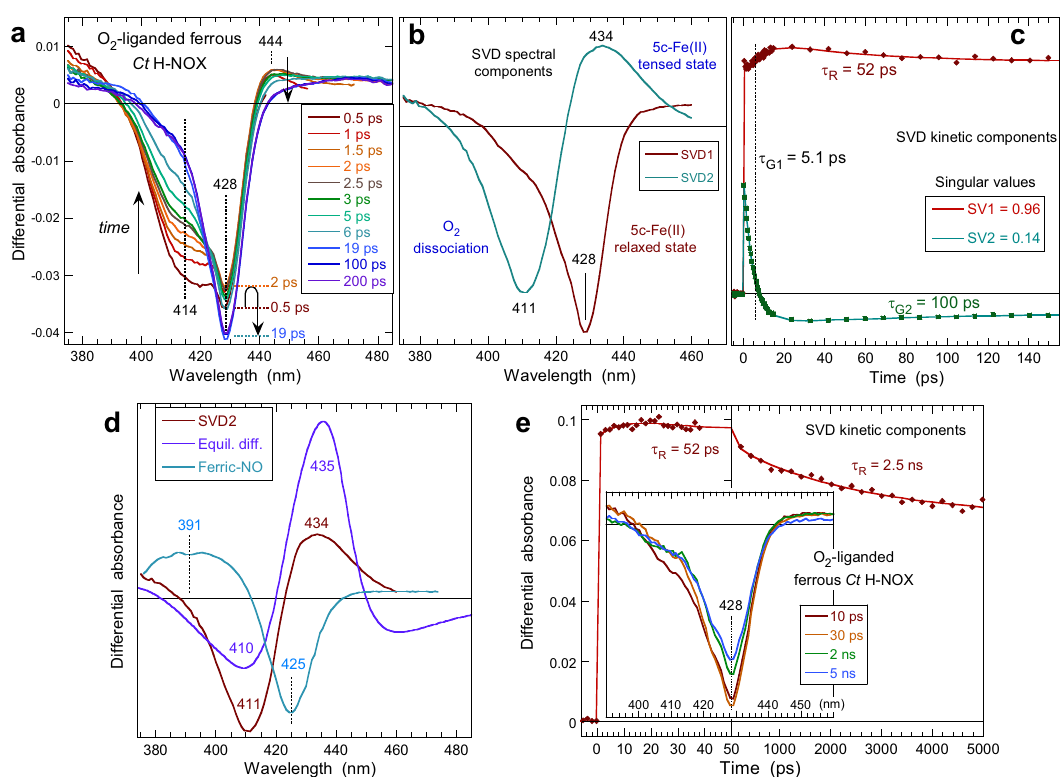
Fig. 2 Dynamics in ferrous O 2 -liganded Ct H-NOX. a Transient difference absorption spectra (spectra at positive delay minus spectrum at negative delay) after the photodissociation of O 2 from ferrous heme at increasing time delay ( λ ex = 564nm). b Spectral components from Singular Value Decomposition analysis of the time-wavelength data matrix of Ct H-NOX – O 2 . c Associated SVD kinetic components fi tted to the sum of two exponential terms and their time constants. The ordinate of the three panels is the difference of absorbance after minus before O 2 dissociation. SVD1 and SVD2 refer to their ranked singular values. d Comparison of the SVD2 spectra for the dissociation of O 2 with the equilibrium difference and the transient spectrum of NO dissociation from ferric Ct H-NOX. e Kinetics of the SVD1 component up to 5